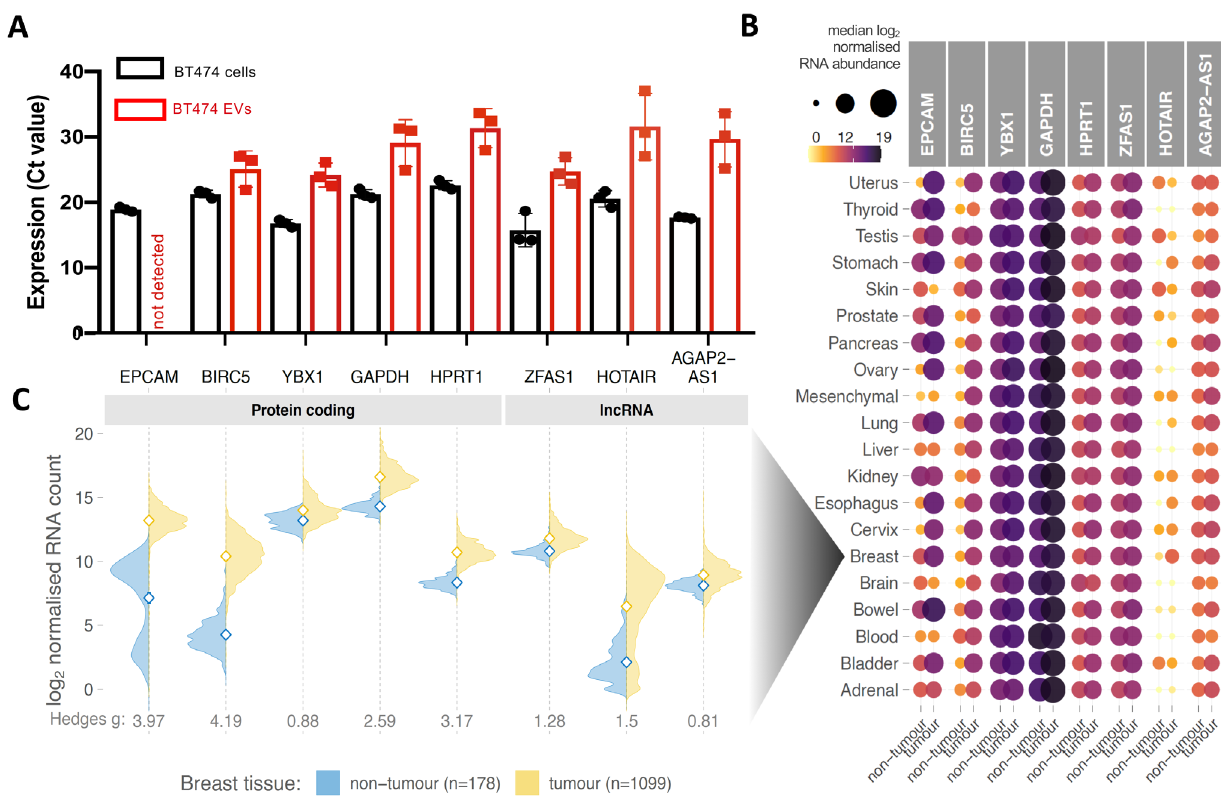
Figure 2. Bioinformatics meta-analysis of BT-474 extracellular vesicle (EV)-associated RNAs in tumour and non-tumour tissue. ( A ) Mean mRNA abundance (Ct value) of five protein-coding genes ( EpCAM, BIRC5, YBX1, GAPDH, HPRT1 ) and three long non-coding RNAs ( ZFAS1, HOTAIR, AGAP2-AS1 ) in BT-474 cells and their EVs. Each data point represents an average Ct value obtained in a PCR experiment using technical duplicates of an independently prepared sample. Three independent experiments were performed. Error bars denote standard errors of the mean. ( B ) Comparison of RNA expression of the gene panel studied in ( A ) between human tumours and their respective non- tumour tissues deposited in TCGA and GTEx portals. Data were manually classified into 20 different organ categories (y-axis) including 8,867 samples across 28 different cancer types and 6,874 samples across 24 non-tumour tissue types. Colour and area of the circles represent median RNA abundance; darker and larger circles indicate higher RNA expression. ( C ) Distribution of RNA expression of studied genes in breast tumours and breast non-cancer tissues. Open diamonds denote means of each population. Hedges g effect sizes indicate a number of standard deviations that separates the tumour and non-tumour groups. Hedges g > 0.8 demonstrates large effect size, i.e., difference between the means clearly stands out from the “noise” within the